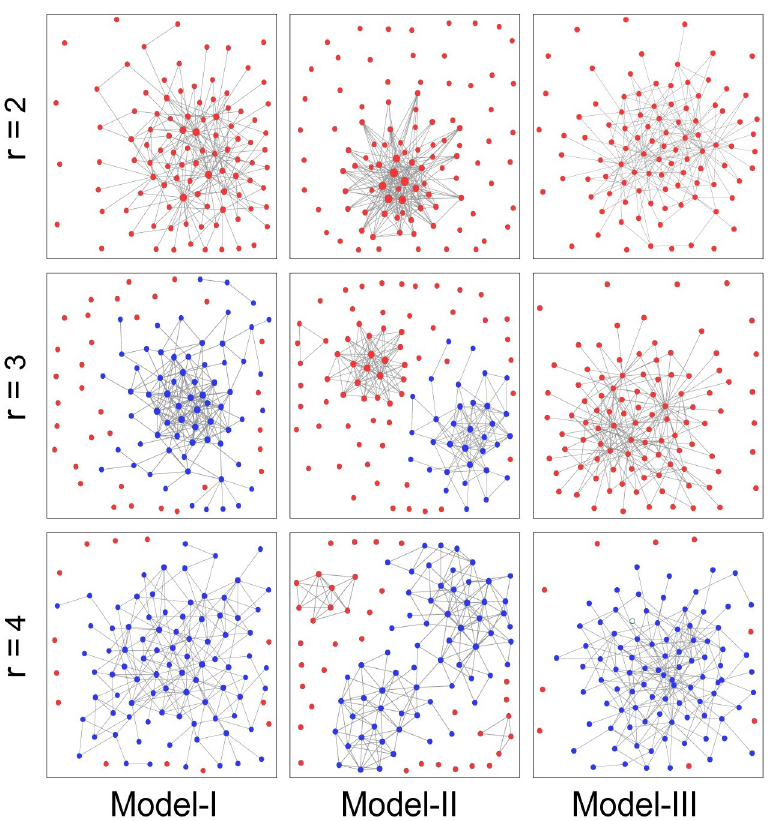
Fig 7. Characteristic snapshots of the network for three partner switching methods with different r, after the cooperation stabilizes. Cooperators and defectors are marked by blue and red, respectively. For Model-I and Model-II , there are a lot of triangles in the network. For Model-I and Model-III , networks have strong connectivity. Parameters: N = 100, t = 10000, T = 20, ^ k ¼ 4 , α = 5, β = 5, and ω = 0.1.